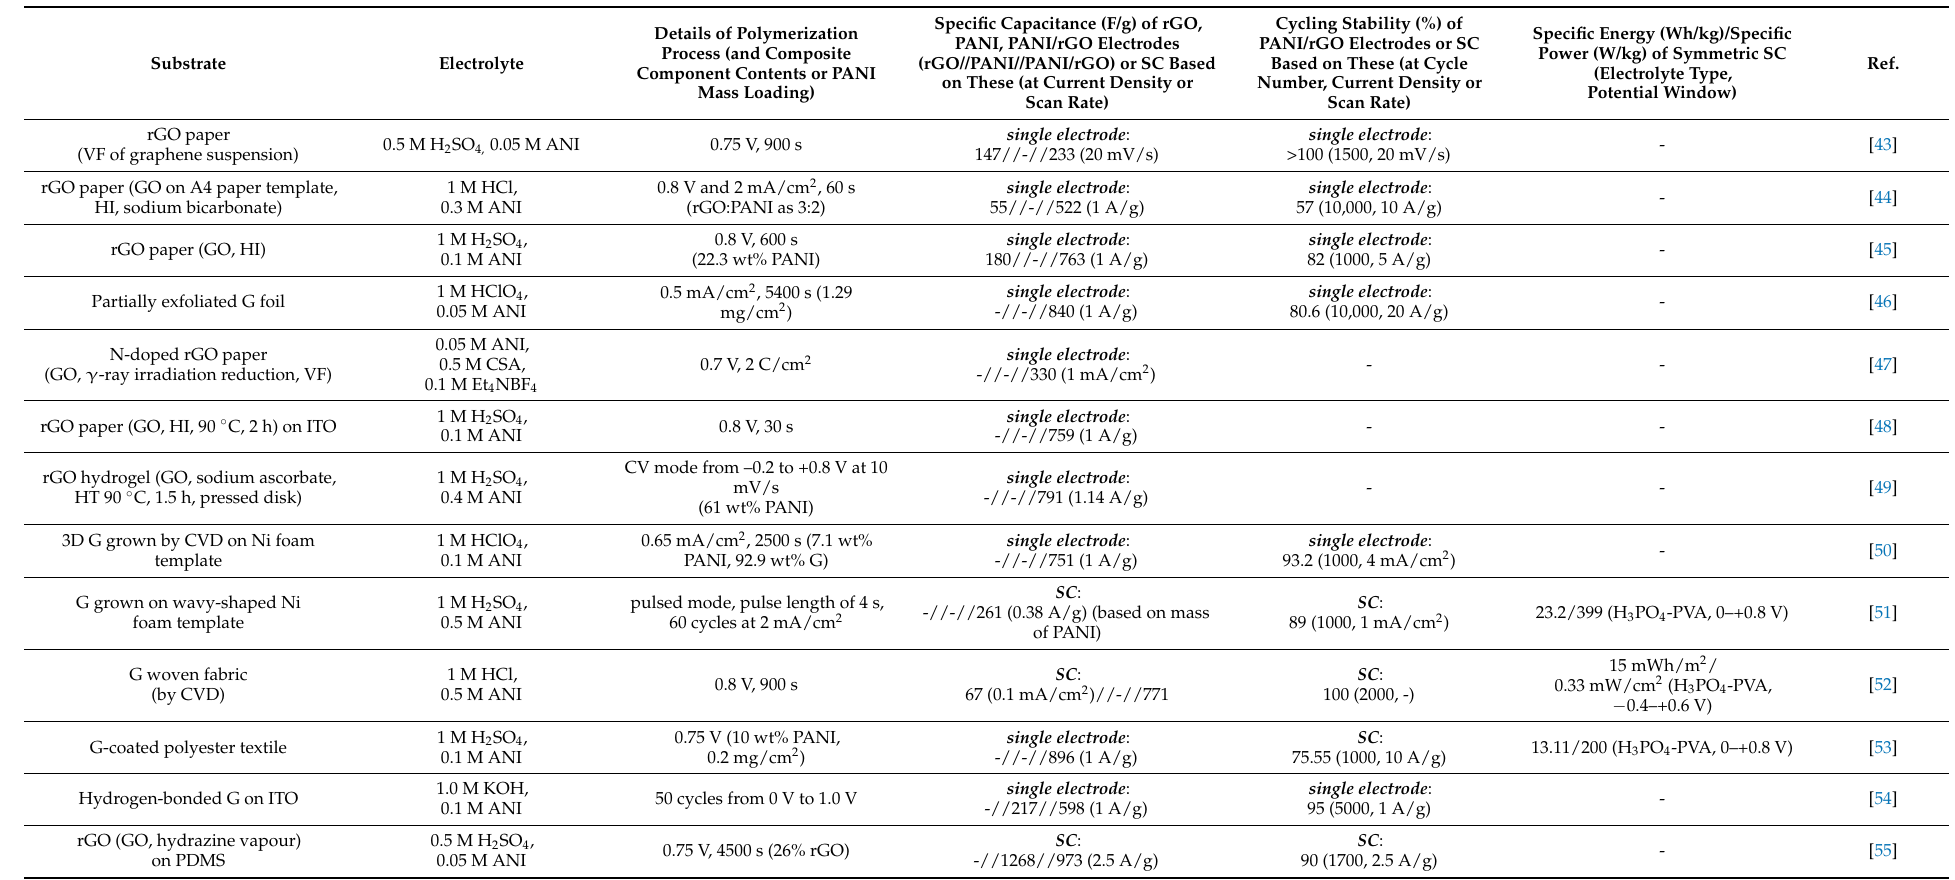
Table 1. Available data of the specific capacitance, cycling stability and summary processing details of the layered PANI/rGO single electrodes measured in the three-electrode systems or full SC , ordered by type of